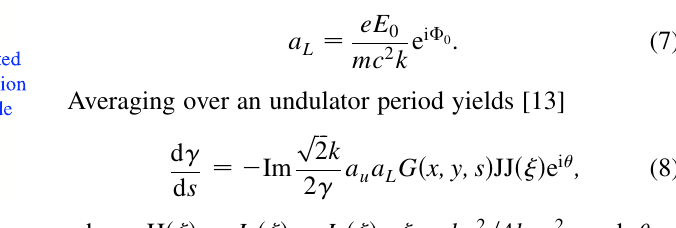
FIG. 1. (Color) A schematic of the FEL configuration chosen here, where a beam, which has a longitudinal distribution that is modulated at one wavelength, then passes through an undulator where it radiates into a harmonic